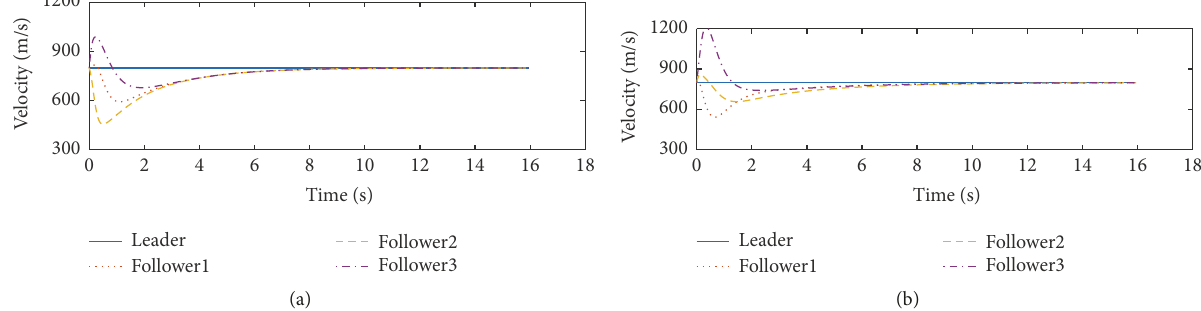
Figure 5: Interceptor velocity curve in the global and local communication topologies: (a) velocity curve in the global communication topology; (b) velocity curve in the local communication topology.